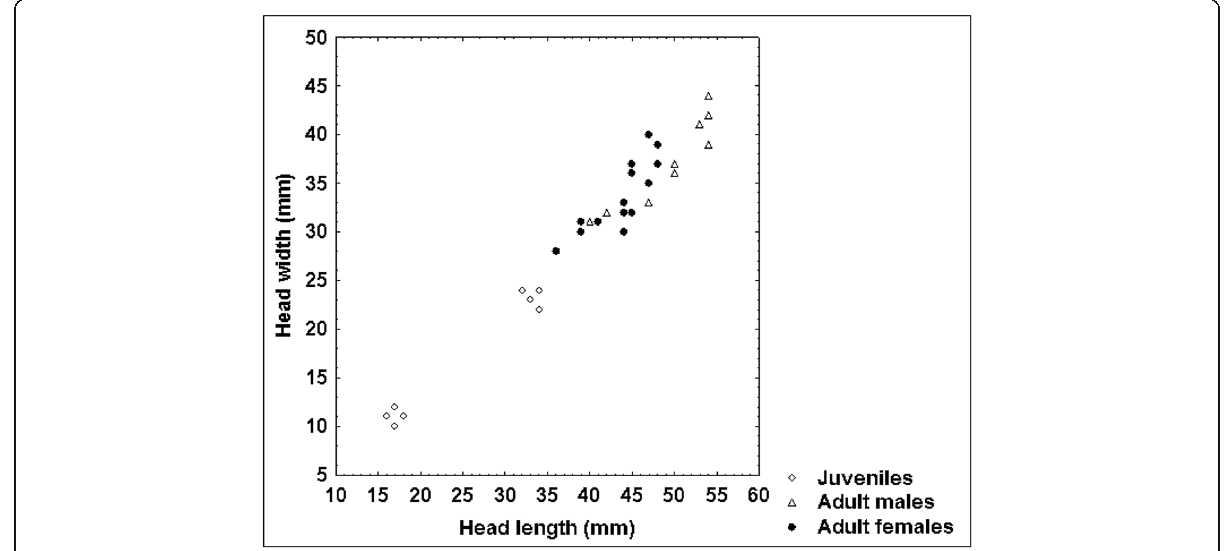
Fig. 11 Relationship between HL and HW in 32 blunt-nosed vipers from Cyprus: R =